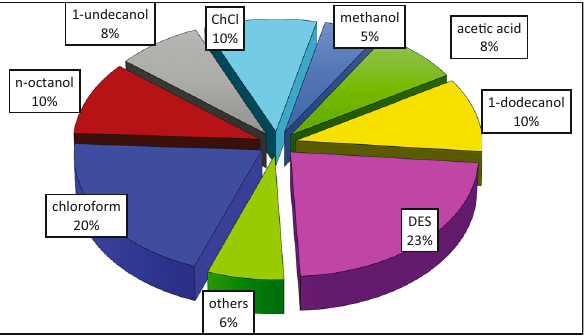
Figure 3: The most used extractants in the AALLME